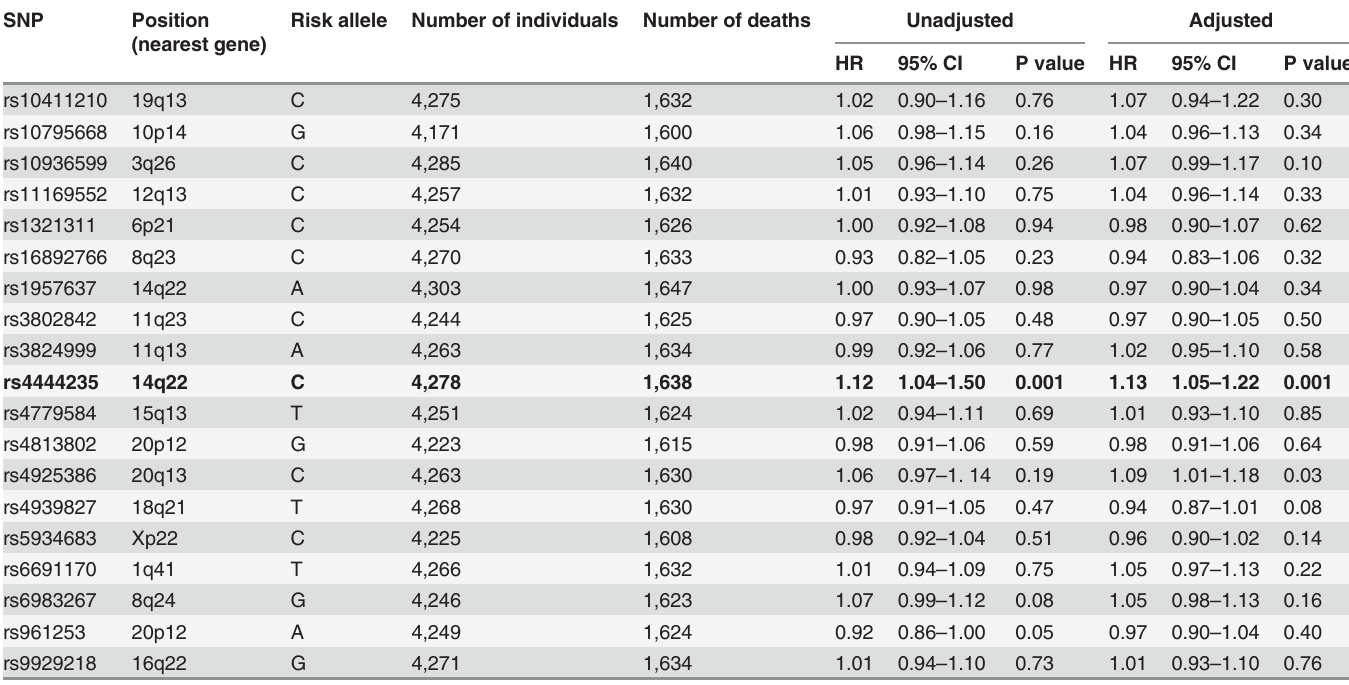
Table 2. Unadjusted and risk-adjusted hazard ratios showing the risk of death within fi ve years of diagnosis in relation to SNP status. SNP Position Risk allele Number of individuals Number of (nearest gene)